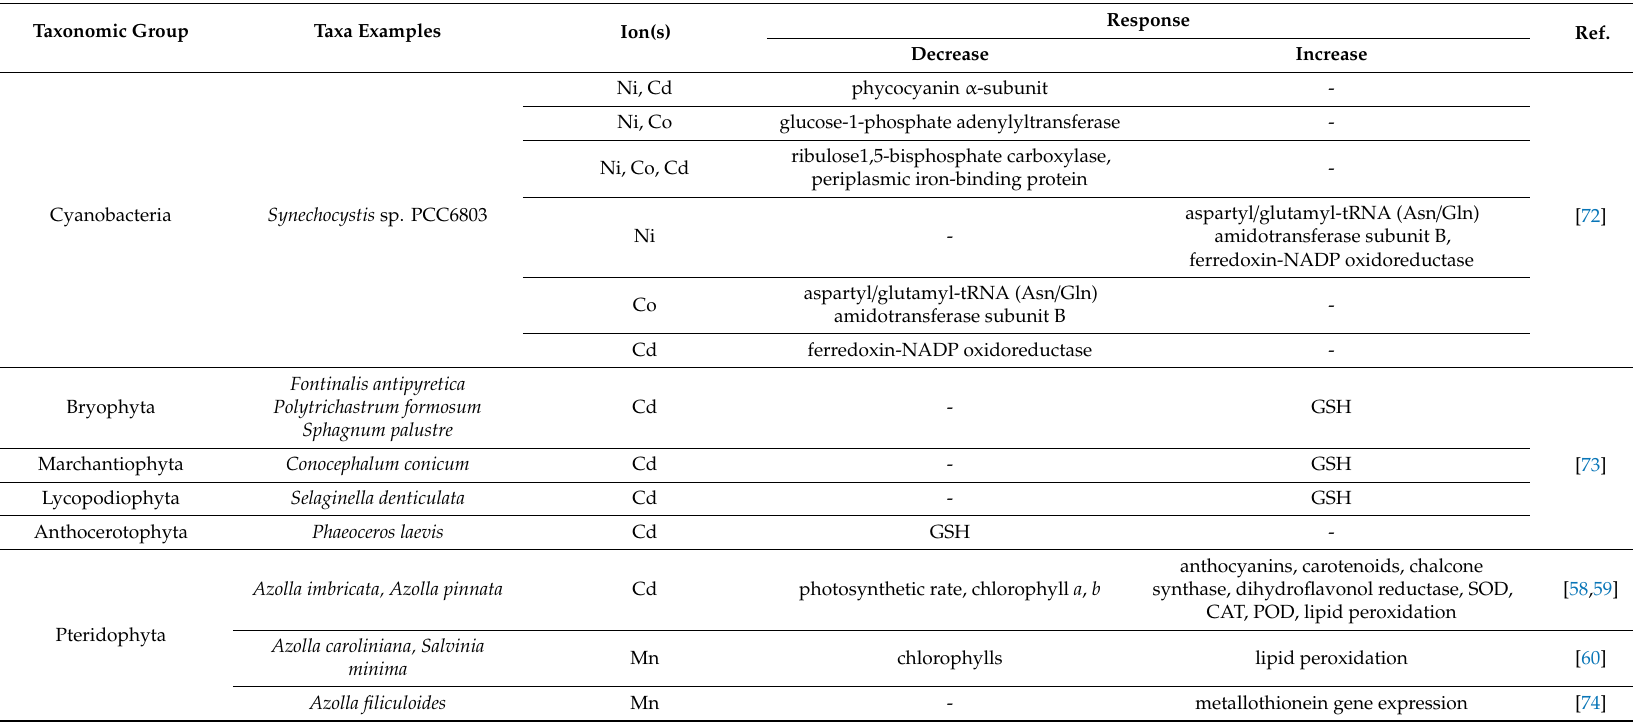
Table 1. The examples of toxic trace elements (TEs) e ff ects on metabolic and growth processes in chosen representatives of diversified taxonomic groups in alphabetical order within the